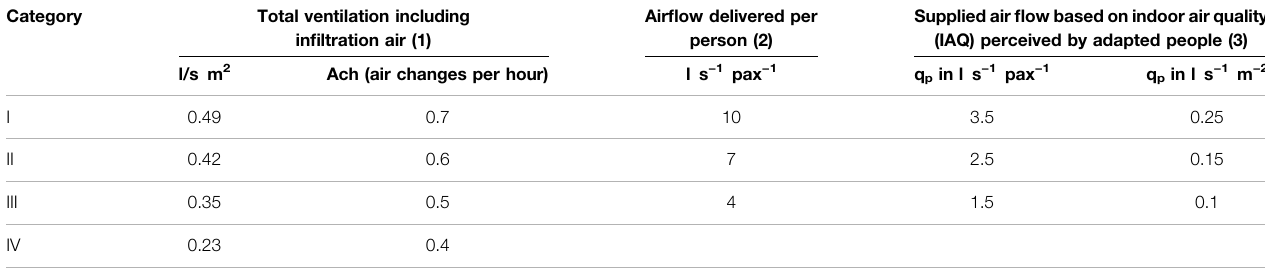
TABLE 2 | Ventilation air fl ow rates, three different calculation methods (1), (2), and (3). Category